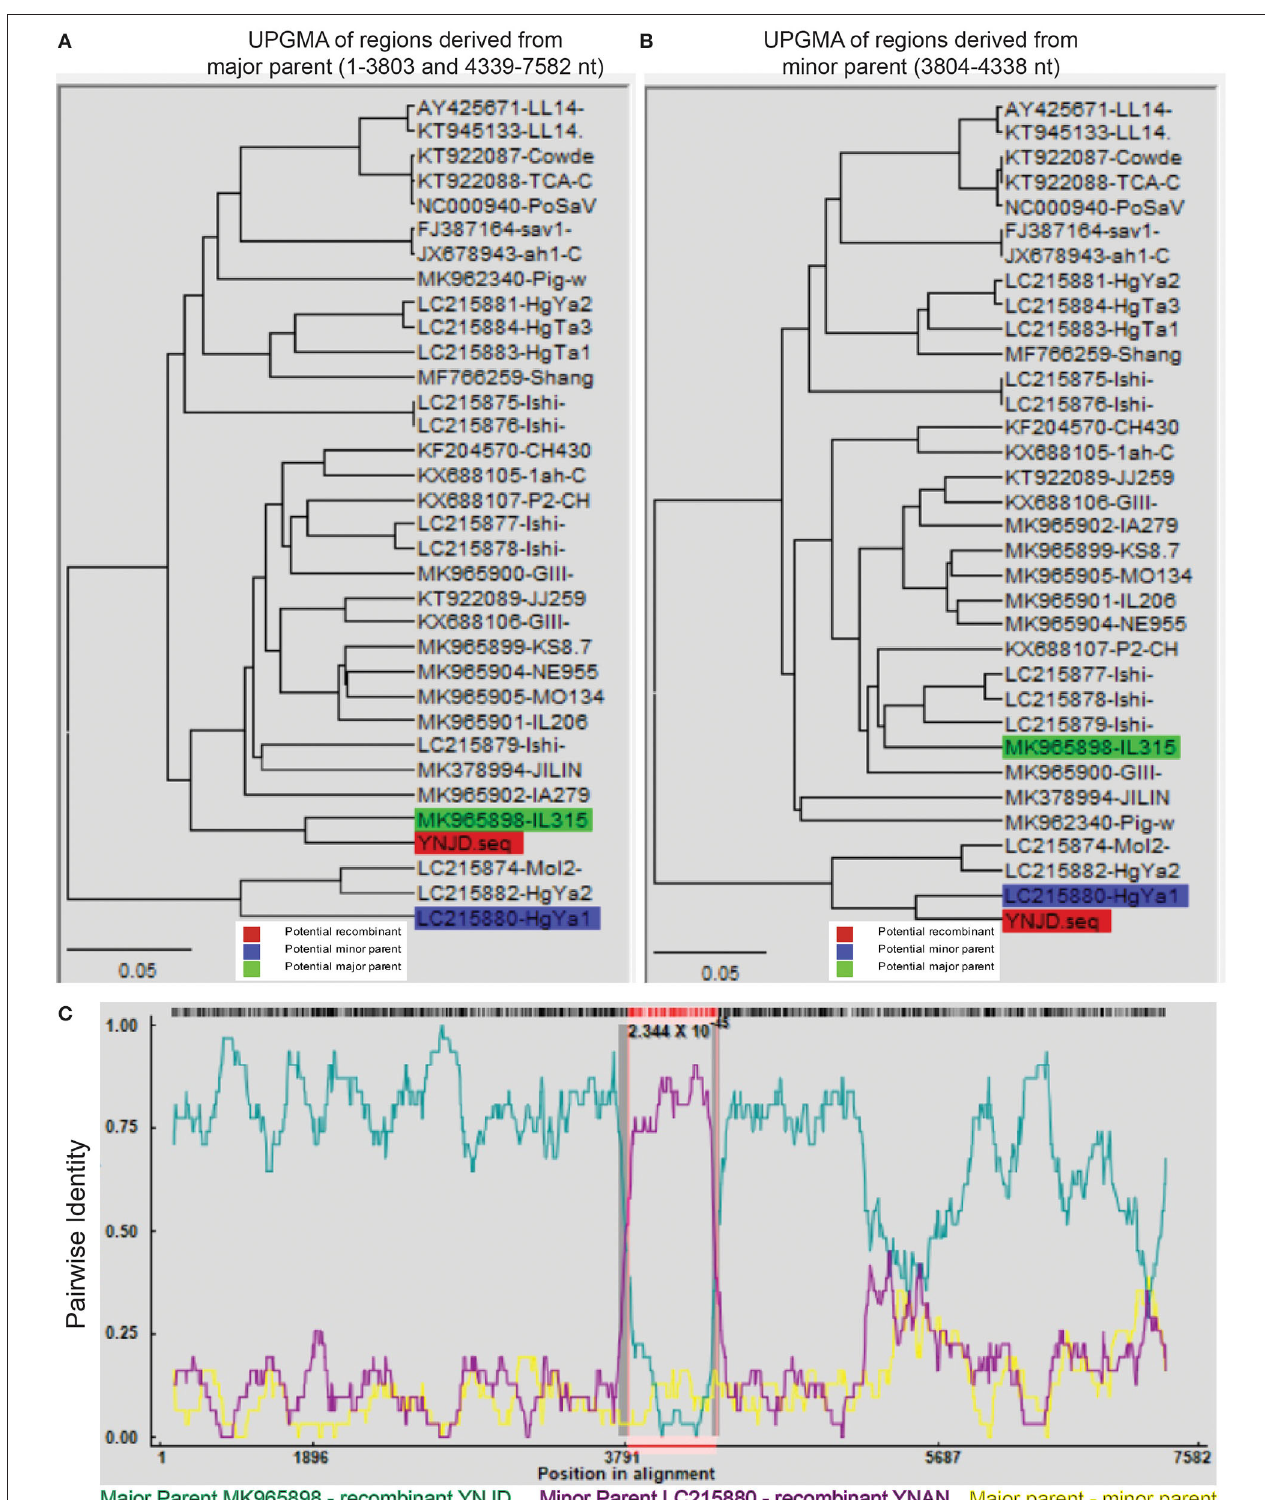
FIGURE 5 | Recombination analysis of Yunnan PoSaV-GIII strain YNJD using RDP v.4 software. Phylogenetic tree was constructed based on the complete SaV genomic sequences using the unweighted pair-group method (UPGMA) (7) to illustrate the evolutionary relationship between the recombinant strain YNJD